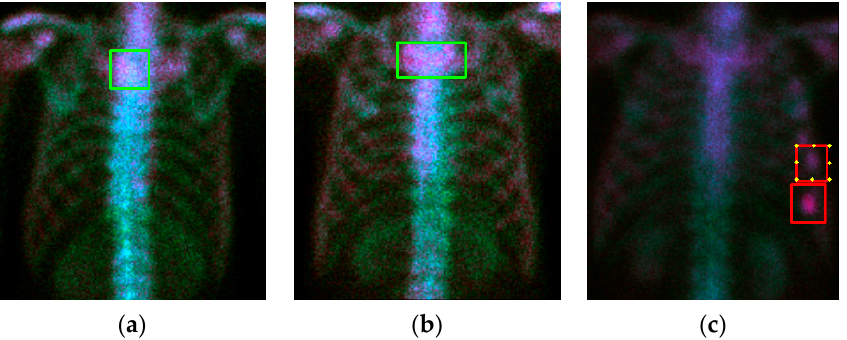
Figure 8. Qualitative detection and classification results (case numbers 73, 132, and 137). ( a ) Nor-